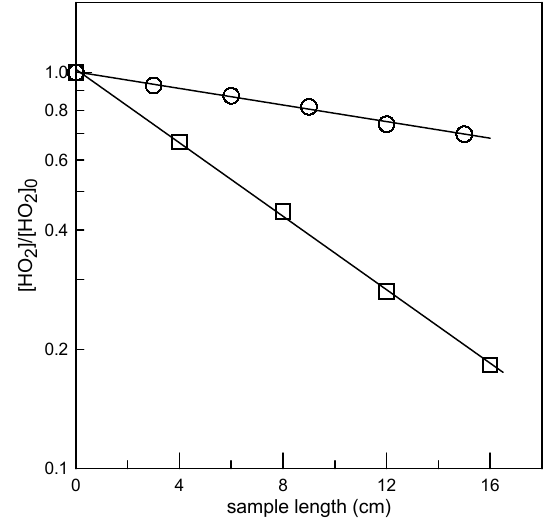
Fig. 3. Example of kinetics of HO 2 consumption in reaction with ATD surface: T = 300K, P = 1Torr, dry conditions, [HO 2 ] 0 = 2 . 0 × 10 12 moleculecm − 3 . Circles and squares correspond to the results obtained using F + H 2 O 2 and Cl + CH 3 OH + O 2 systems to produce HO 2 and with samples of 2.5 and 2.8mgcm − 1 after 75 and 20min of exposure, respectively. HO 2 is monitored as NO + m/z = 46 (see